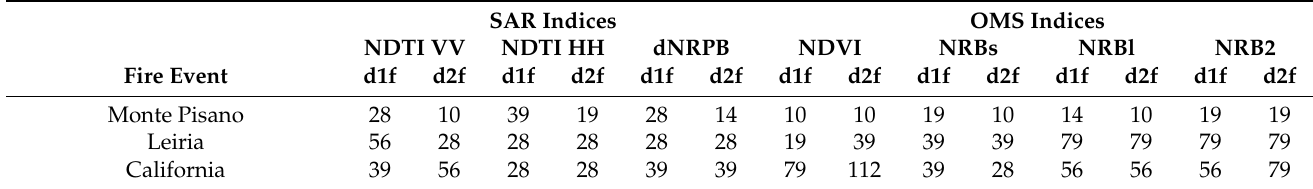
Table 4. Optimal bin number values of both SAR and OMS indices for d1f and d2f in respect to the fire event case studies.